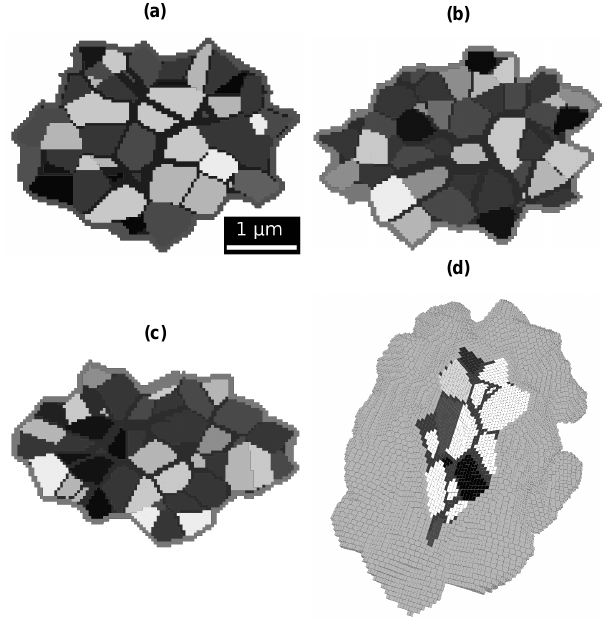
Figure 3. Example cross-sections of Case 1 versions of all three of the ensemble constituent particles (Panels a–c ), and a three- dimensional rendering (Panel d ) of the particle in Panel (a) , with a part of the particle cut out to reveal the inner structure. Different shades of gray correspond to different minerals. The scale bar in Panel (a) shows the approximate size of the features at the largest particle r used in this study,